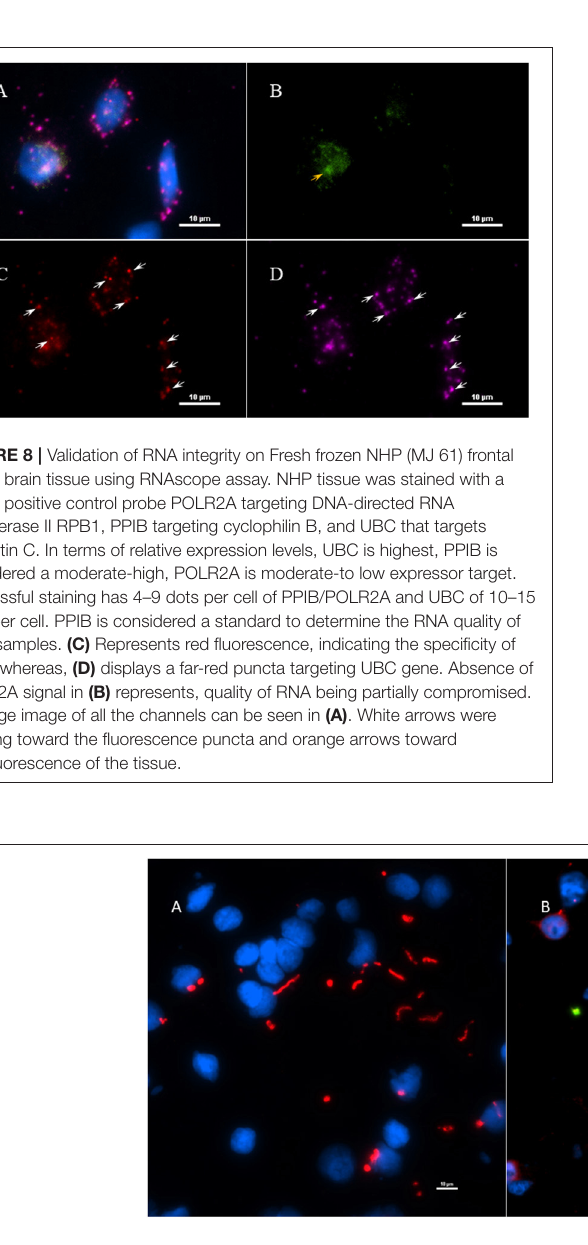
FIGURE 9 | Technical validation of RNAscope assay performed on NHP (MJ 61) frontal cortex brain tissue cultured with Borrelia burgdorferi . (A) Fixed-frozen tissue: Spirochetes are highlighted by an intense red (cy3, PerkinElmer catalog number NEL744001KT), indicating strong specificity of B. burgdorferi probe ( B. burgdorferi probe targeting the 23S rRNA transcript; Advanced Cell Diagnostics catalog number 468211). (B) Fresh-frozen tissue: RNAscope assay combined with Immunofluorescence (IFA). Initially, spirochetes were probed with 23S rRNA and detected using fluorescein fluorophore (PerkinElmer catalog number NEL741001KT). To counterstain the spirochetes with IFA, tissue was incubated with primary anti-FlaB mouse monoclonal antibody H9724 and goat anti-mouse IgG2a Alexa Fluor 594 (Thermofisher catalog number A-21135). White arrow indicates an intact spirochete showing the colocalization of RNAscope probe with monoclonal antibody with subsequent green and red